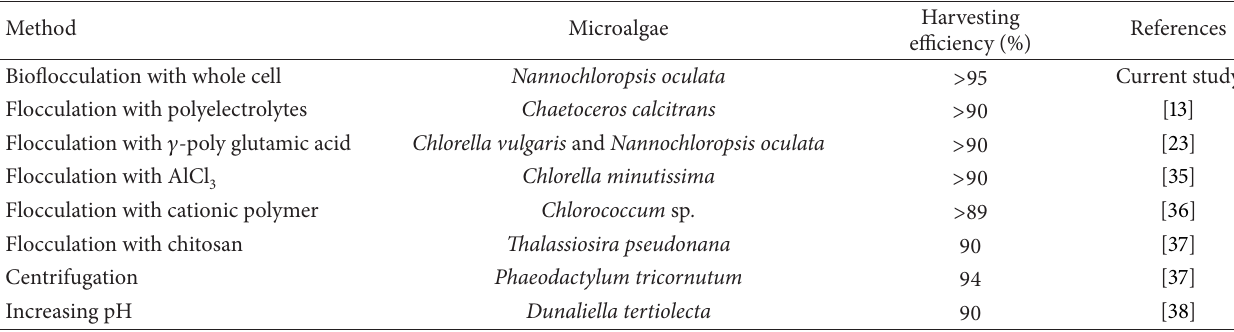
Table 4: Comparison of different harvesting methods and their